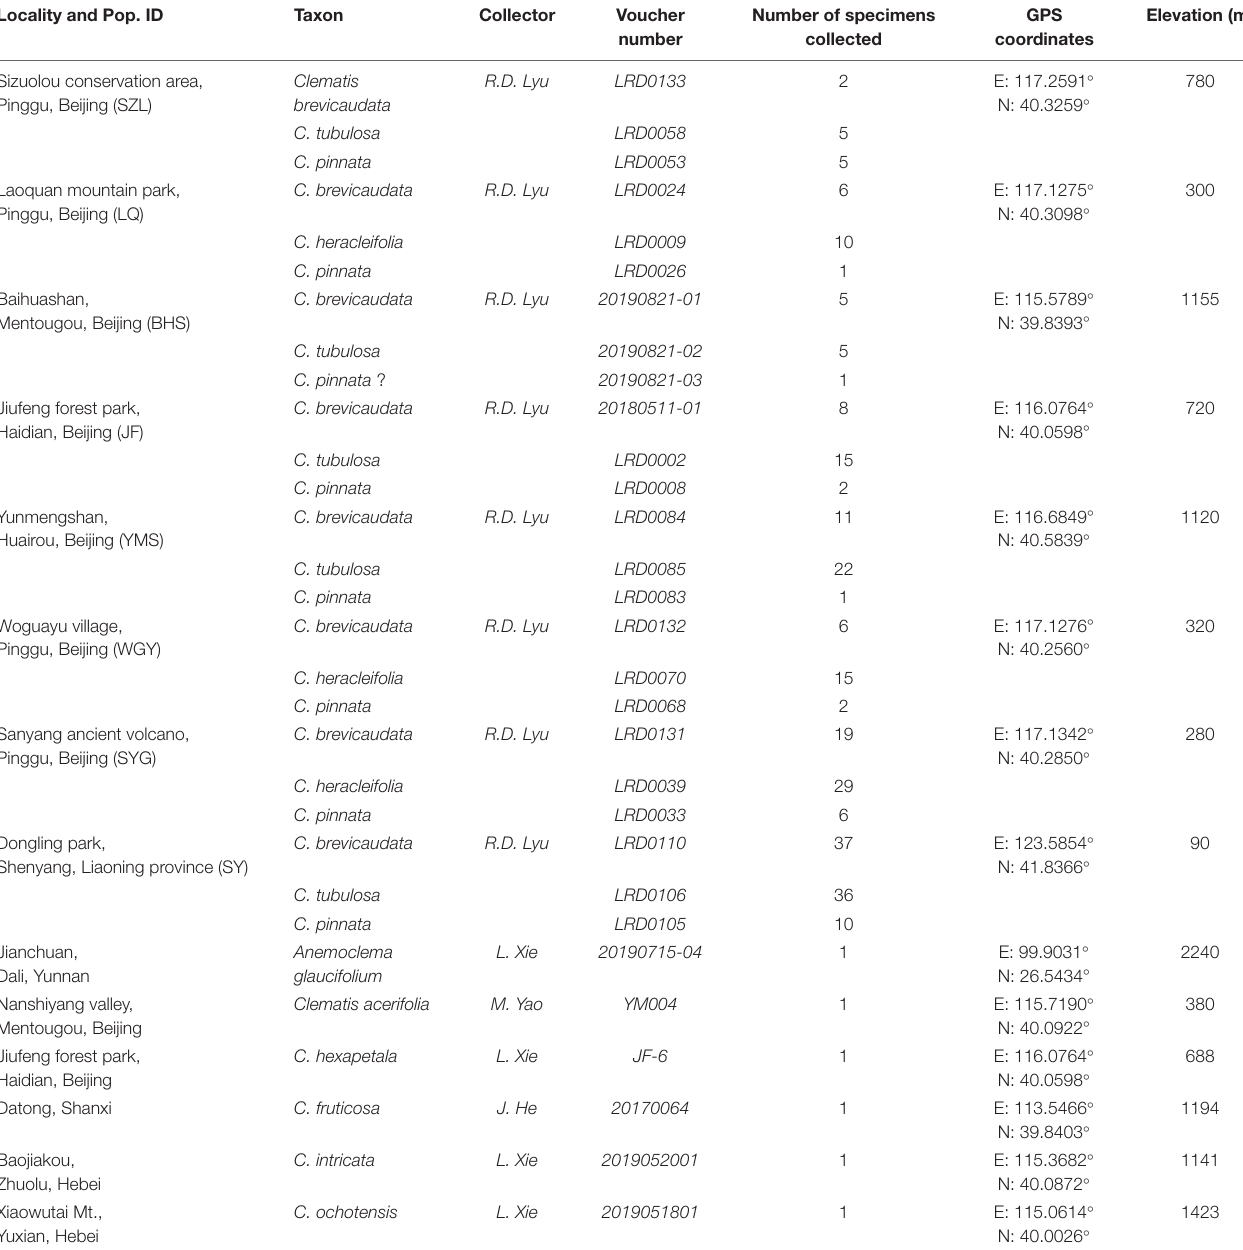
TABLE 2 | Locations of the population sites of Clematis pinnata and its putative progenitors collected in this study. Locality and Pop.